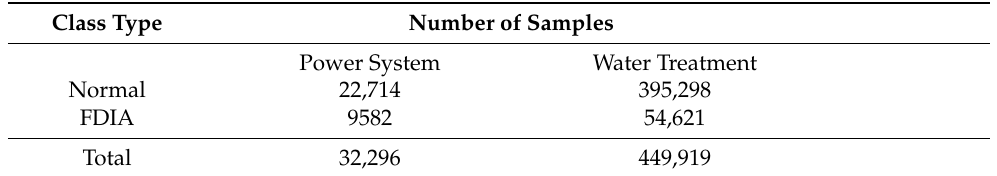
Figure 1. Number of samples per class in the dataset. Table 2. Distribution of the classes (normal and FDIA) in the